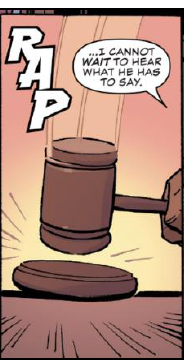
Figure 11. Panel from Soule’s Daredevil: Back in Black Vol. 5: Supreme #22, 2017. Image Credit: Goran Sudžuka © 2017 Marvel Characters,